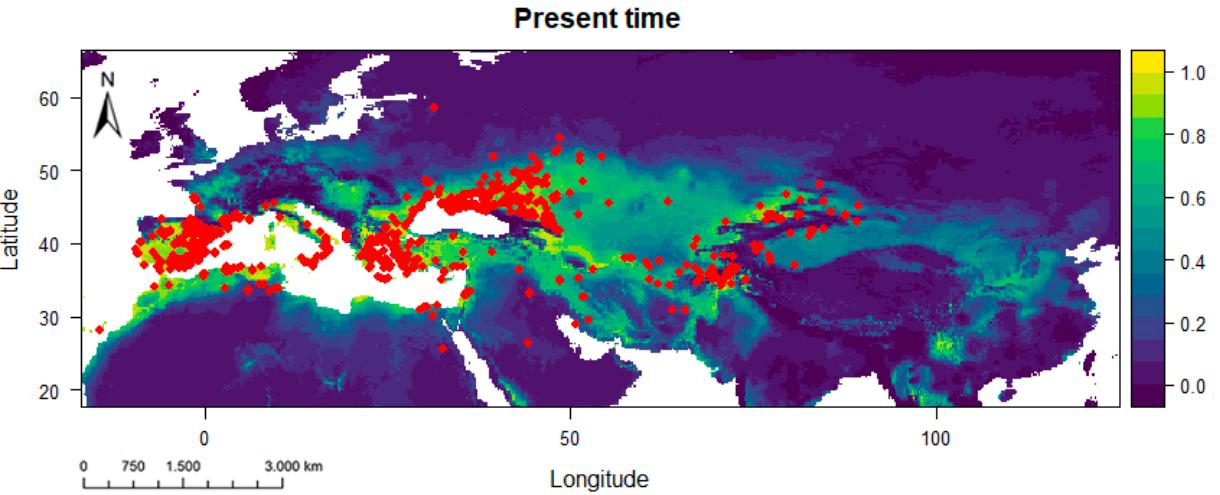
Figure 2. The present-time distribution of Cynanchum acutum L. (ranges from 0 to 1) and occurrence data visualized by red dots used in ecological niche modelling.